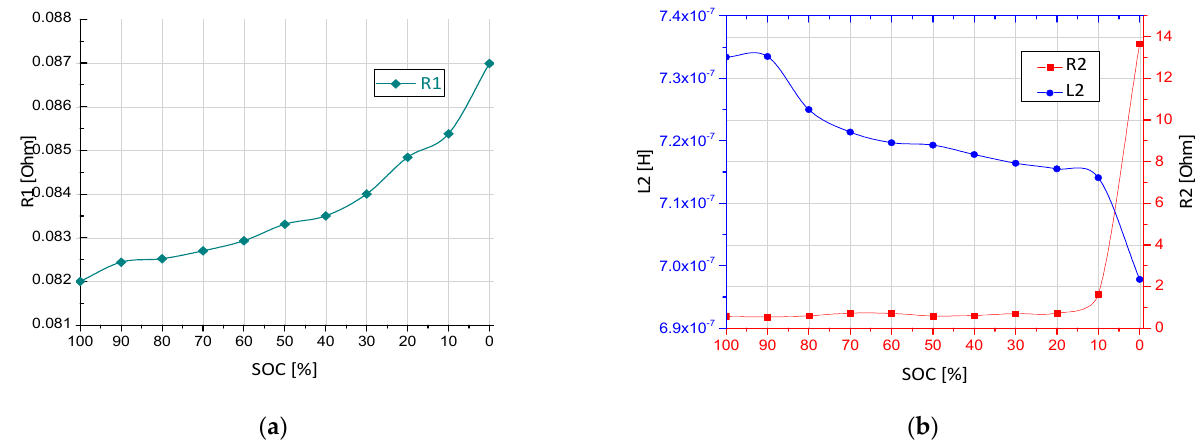
Figure 6. High frequency equivalent circuit parameters: ( a ) R1 parameter and ( b ) L2 and R2 parameters.